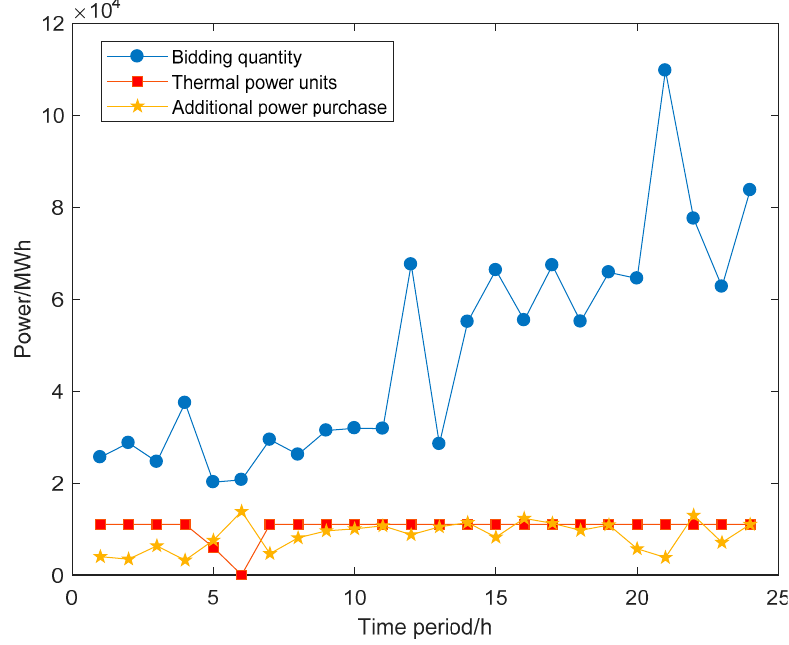
Figure 7 Figure 7. The optimal decision-making under the most pessimistic